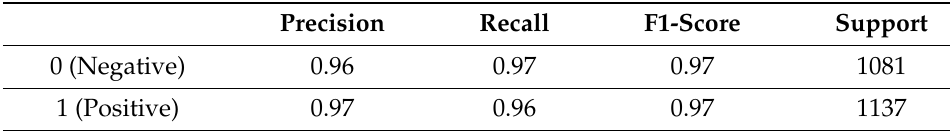
Figure 6. Confusion matrix for SVM. Table 3. Classification report of SVM on the test